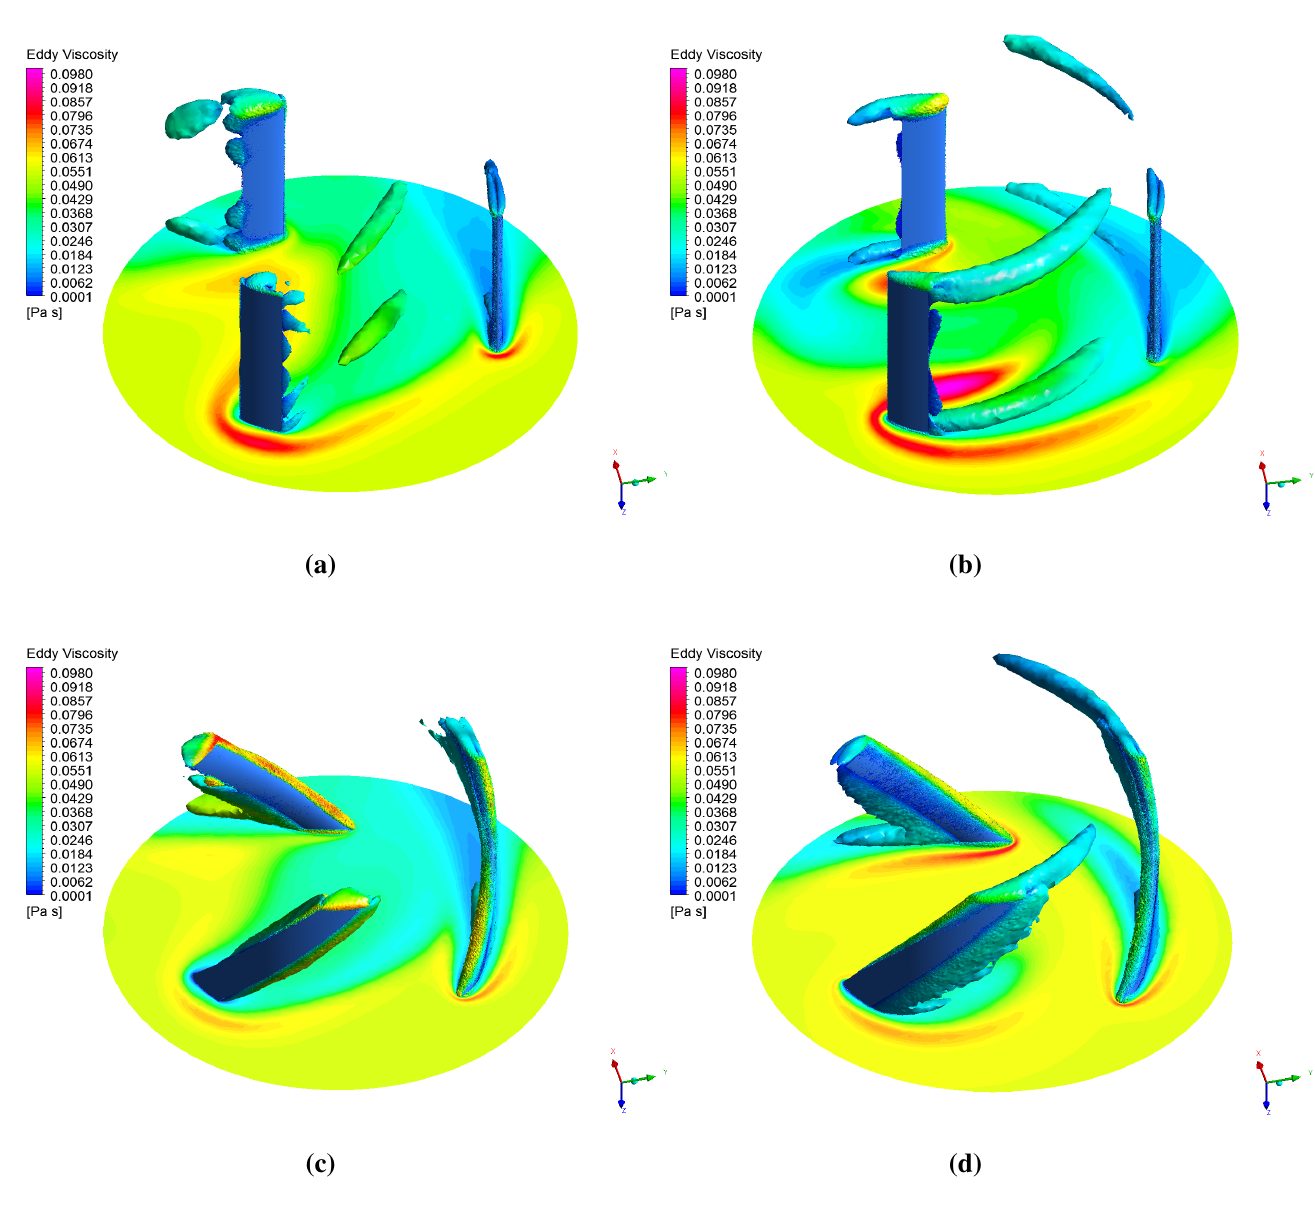
Figure 14. Tip vortex diffusion. ( a ) Straight ( ψ = 0 ◦ ) 60 RPM; ( b ) Straight ( ψ = 0 ◦ ) 120 RPM; ( c ) Helical ( ψ = 60 ◦ ) 60 RPM; ( d ) Helical ( ψ = 60 ◦ ) 120